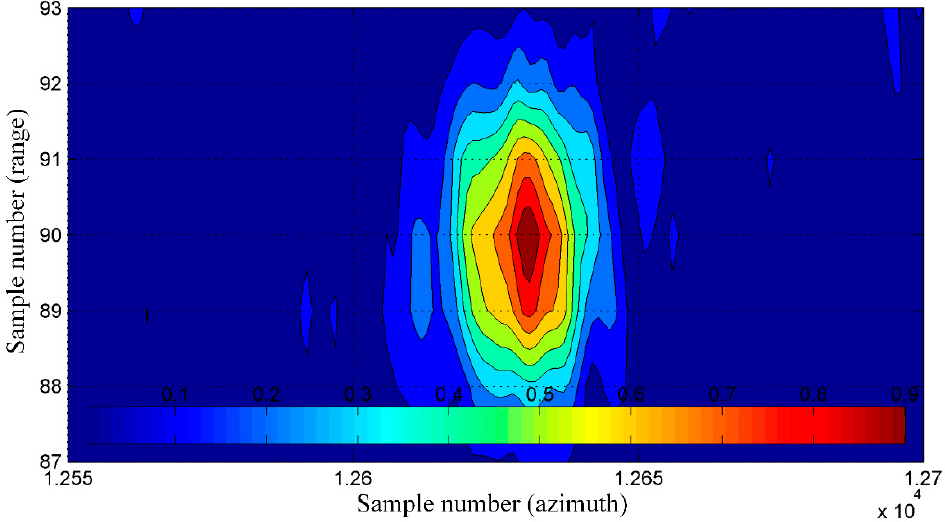
Figure 13. The normalized amplitude of the selected corner reflector pixels—the INS-based MOCO.